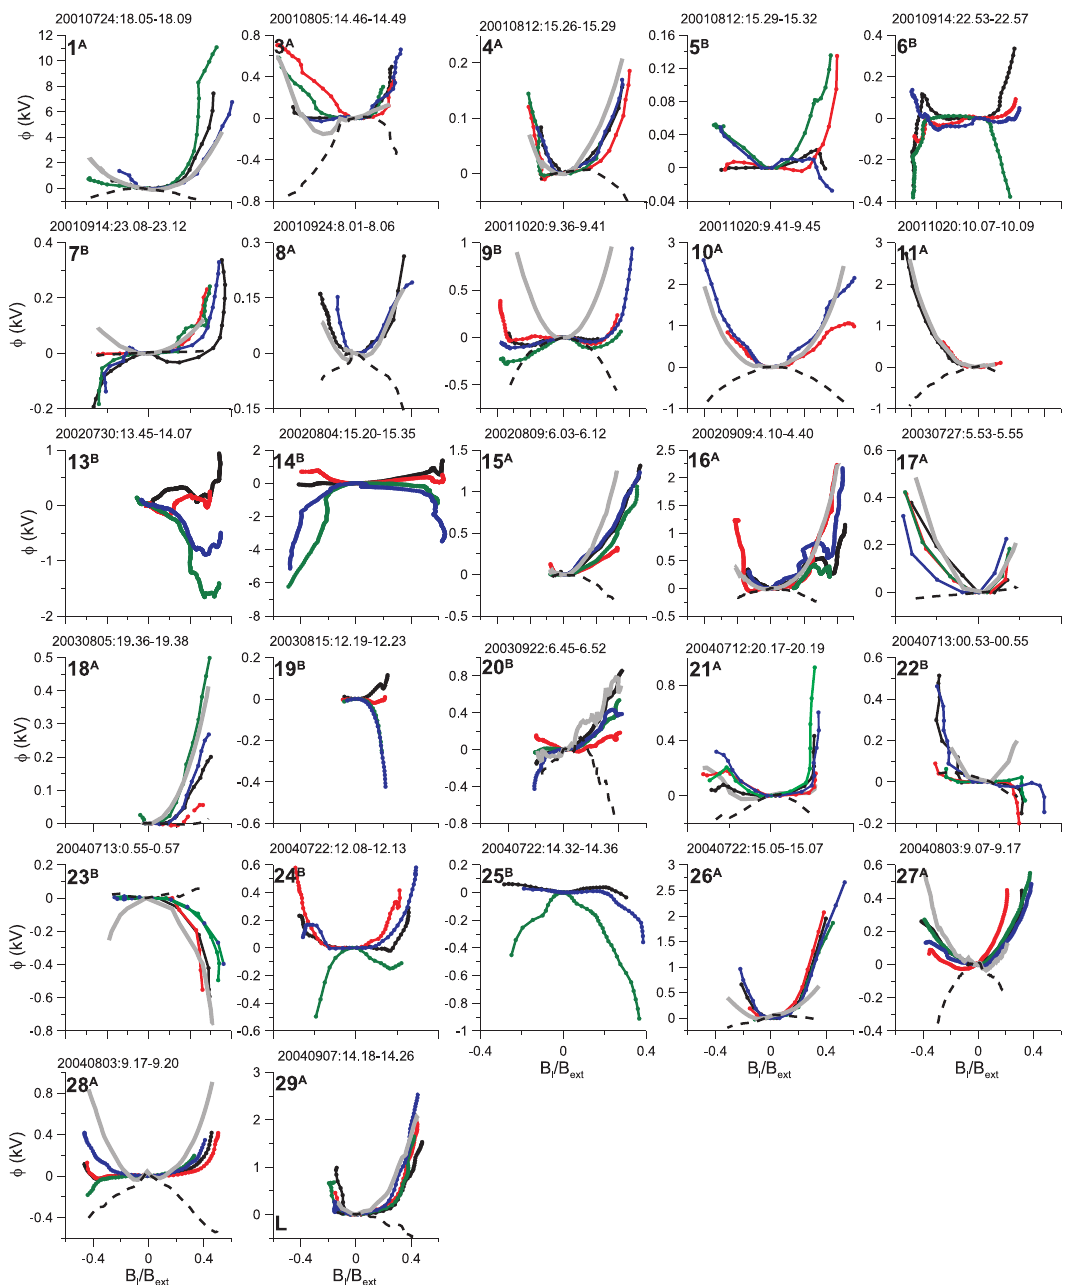
Fig. 11. Electrostatic potentials corresponding to electric fields E (α) n − E (α) (black, red, green and blue curves correspond to C1, C2, C3, n 0 and C4, respectively). Black dashed curves present profiles of theoretical potentials, which are due to the electron pressure gradient only. The gray curves present profiles of theoretical potentials derived from the Ohm’s law under the assumption that the electron current density is comparable to the total current density. Central ticks on horizontal axes correspond to B l = 0, while one large tick interval is equal to